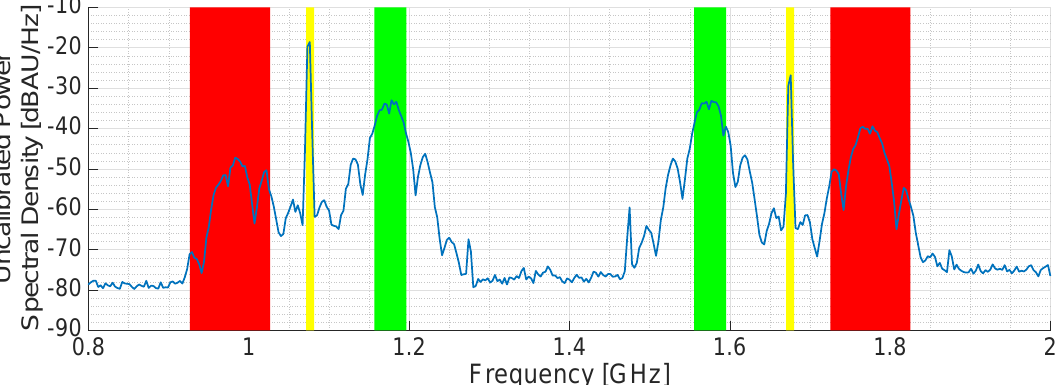
Figure 11. Measured spectra of the transmitted calibration signal at L1/E1 frequency band ( right ), and at L5/E5a frequency band ( left ). In green, the region of the spectrum that will be used for calibration. The aliases of the up-conversion are highlighted in red. The local oscillator leakages are highlighted in